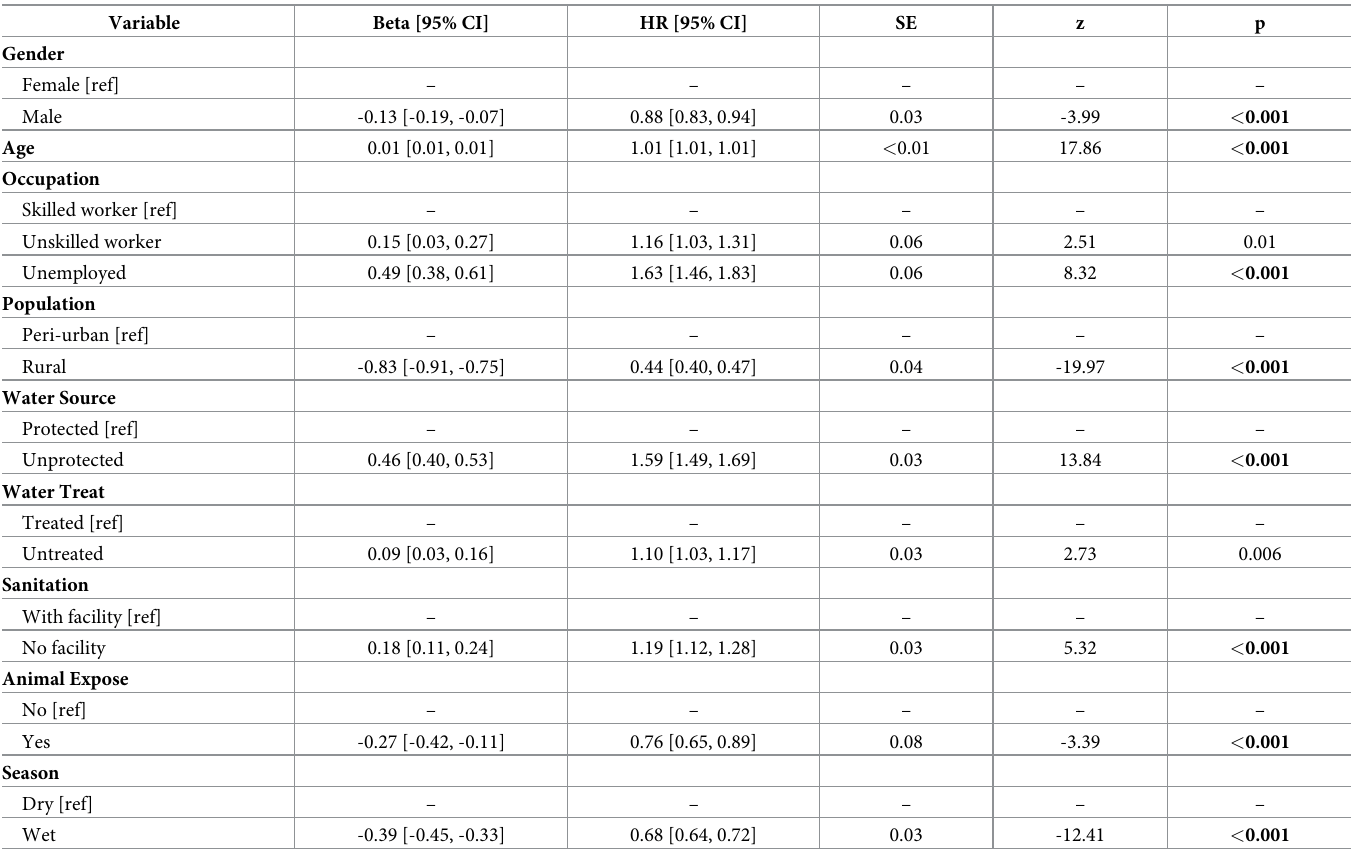
Table 6. Cox survival regression model of likelihood of acquiring diarrhea.